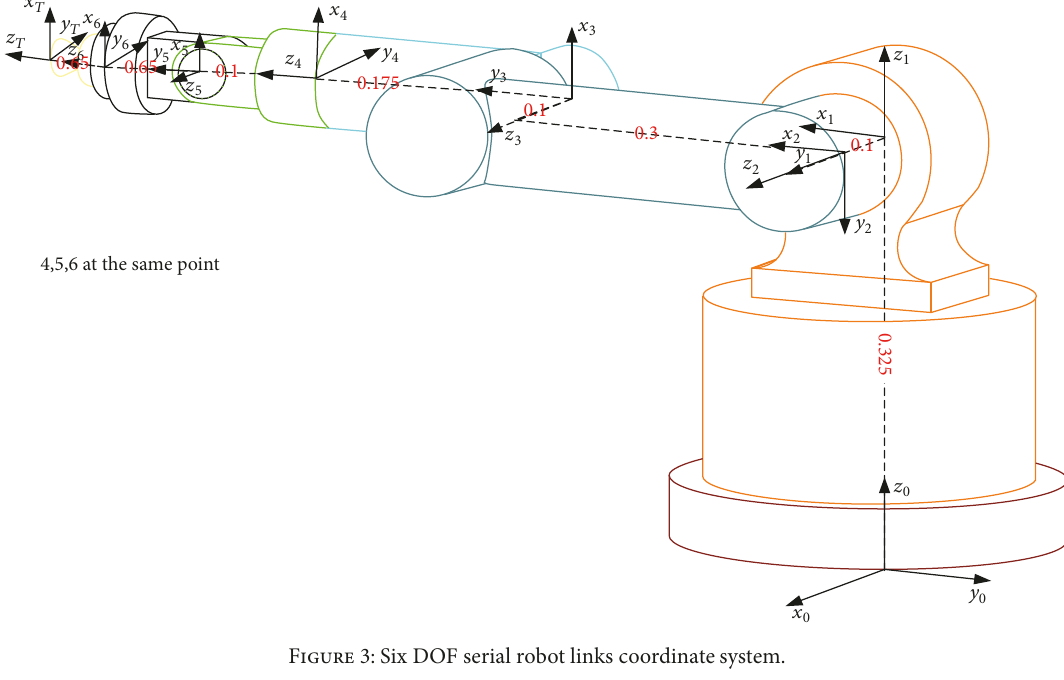
Figure 3: Six DOF serial robot links coordinate system.